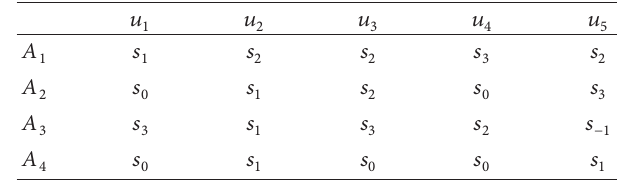
Table 1: The evaluation values of four alternative hubs given by expert 𝑑 1 .